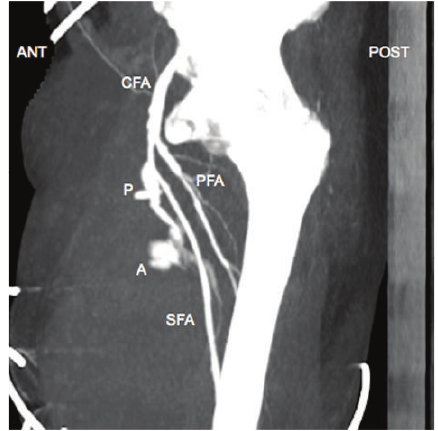
Figure 2: Sagittal computed tomography angiography image of the right groin demonstrates a large pseudoaneurysm (P) commu- nicating with the right superficial femoral artery (SFA) through a pseudoaneurysm neck (N). Common femoral artery (CFA). Profunda femoris artery (PFA). Active bleeding (A).